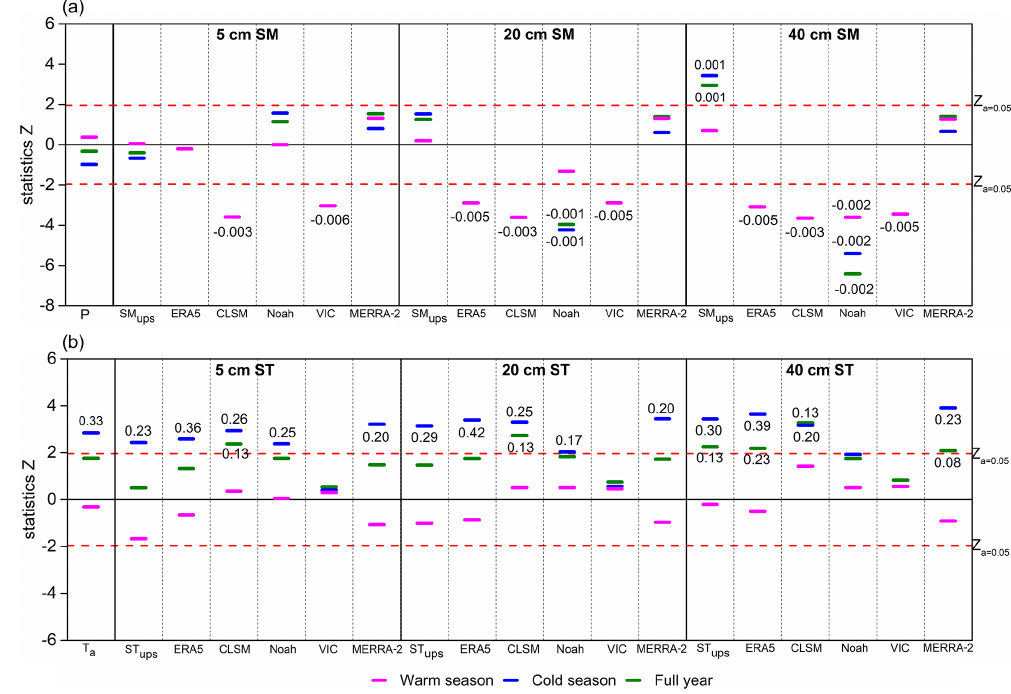
Figure 9. Same as Fig. 6 but for the Shiquanhe network from 2011 to 2018.